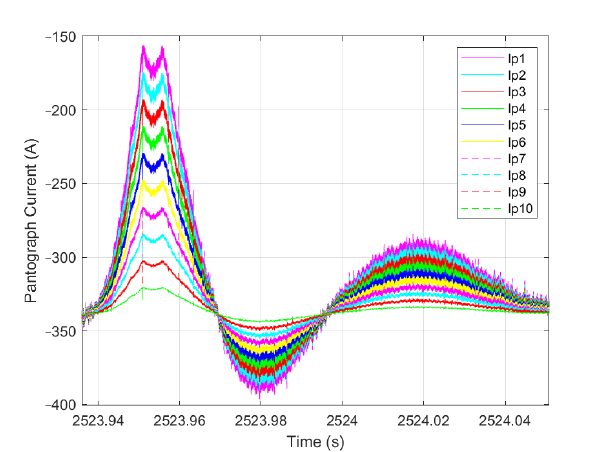
Figure 15. Pantograph current I p1 of arc event 11, along with scaled current versions I p2 to I p10 , respectively, for scaling factors 0.9 to